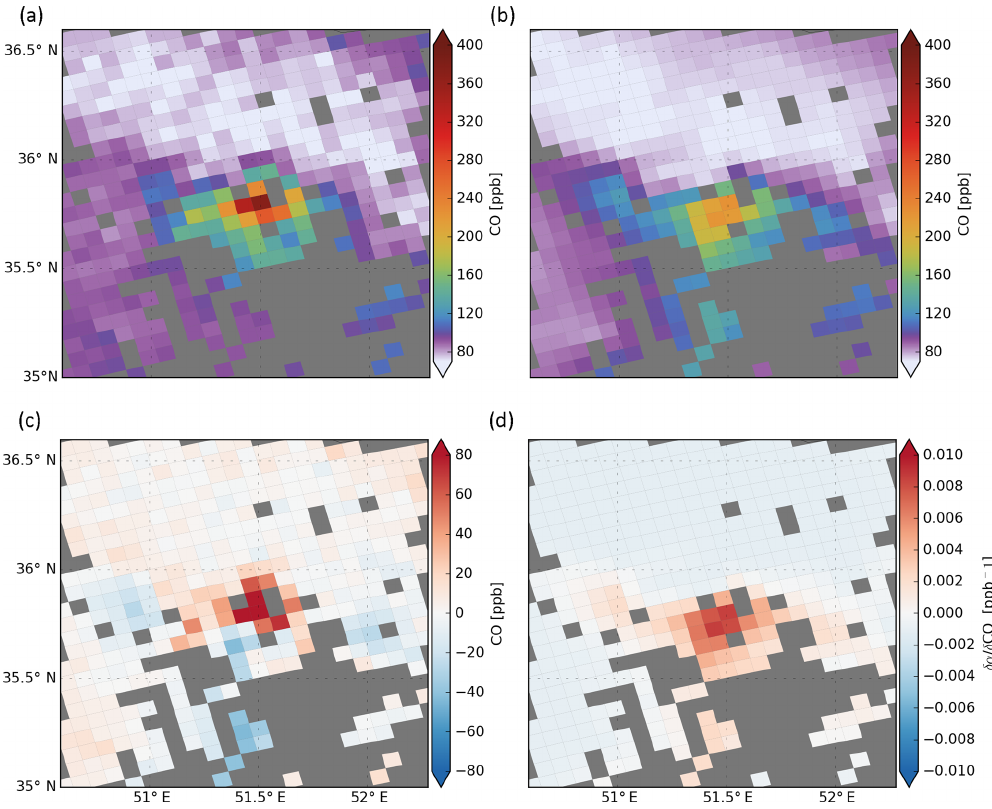
Figure 5. TROPOMI CO retrieval above Tehran on the 18 December 2017 (a) , the collocated WRF simulation scaled to the TROPOMI data (b) , the difference between the TROPOMI and scaled WRF data (TROPOMI − WRF, c ), and the sensitivity of fitting the WRF data to the TROPOMI retrieval (d) .